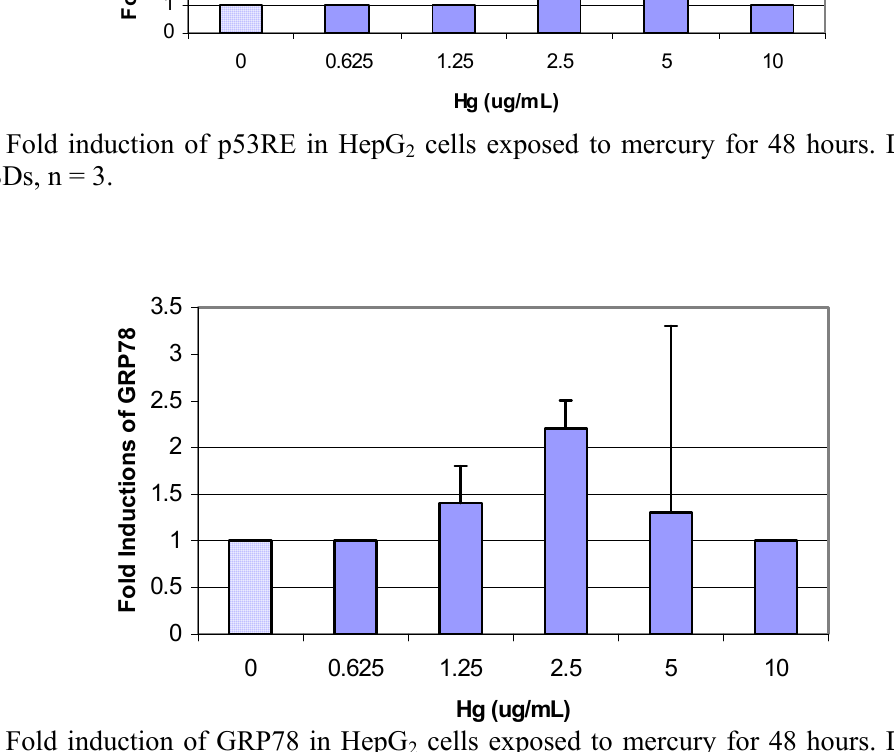
cells exposed to mercury for 48 hours. Data represent 2